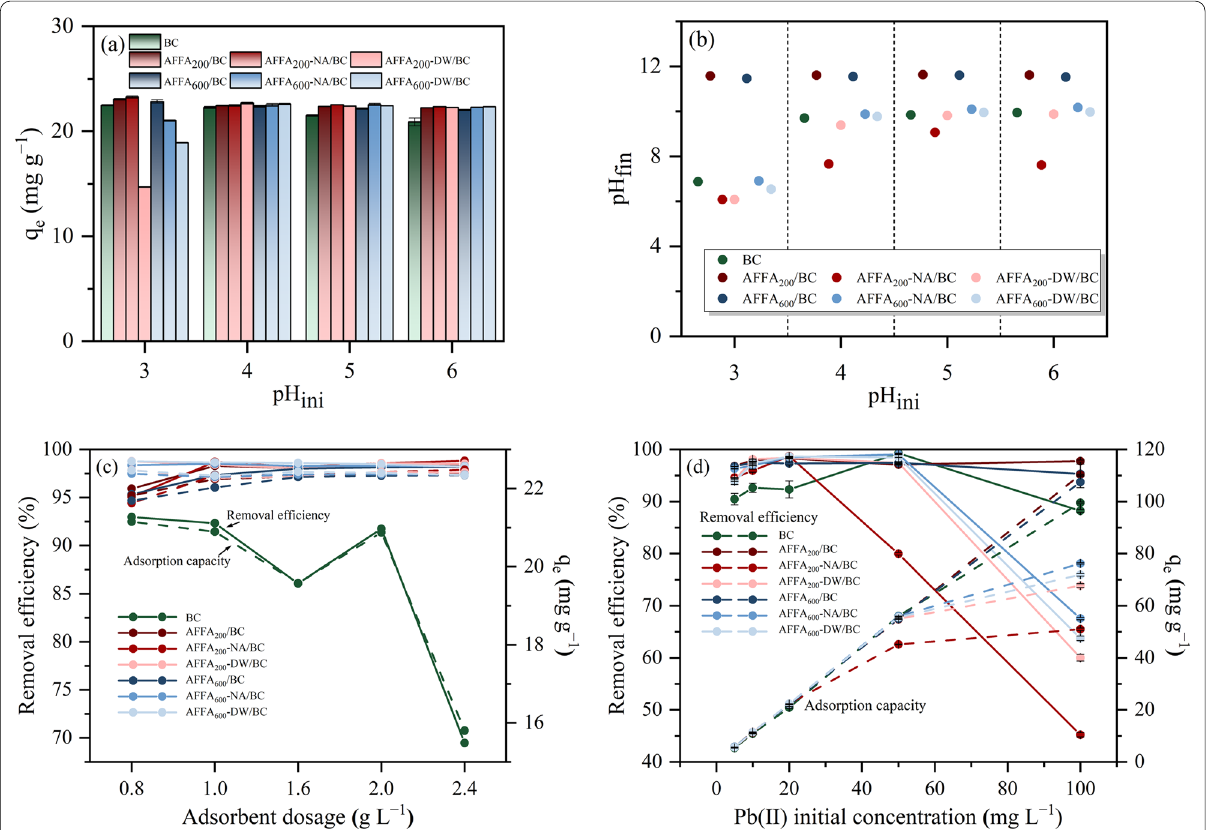
Fig. 4 Influence of a initial solution pH on the Pb(II) adsorption capacity of BC and AFFA/BC and b solution pH before and after adsorption; Pb(II) adsorption by BC and AFFA/BC at c different dosages and d initial